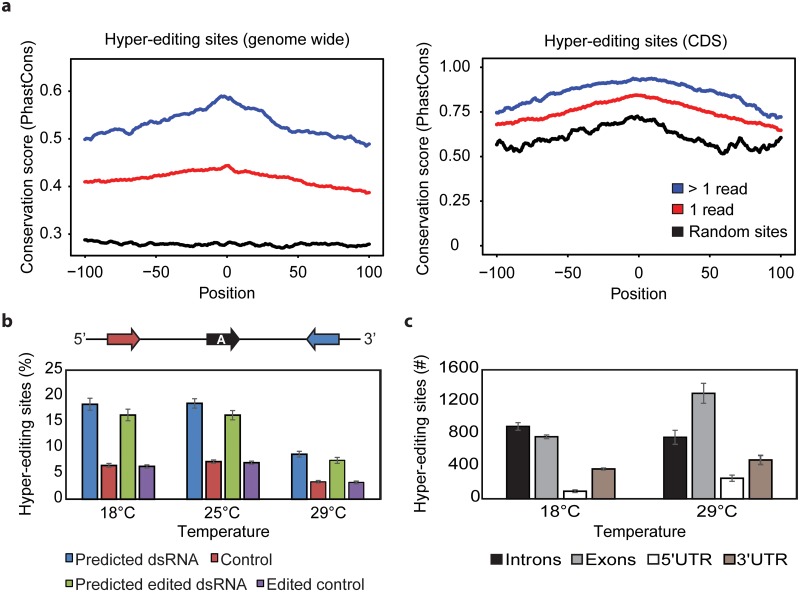
Editing sites at lower temperatures are edited more frequently and are more commonly flanked by complementary sequences.(A) Mean conservation (PhastCons) score of hyper-edited sites. Position 0 indicates the position of editing site. Blue line denotes conservation mean for editing sites supported by more than one event, red line denoted conservation mean for editing sites supported by only one event, and black line represents background conservation of chosen randomly adenosines. Left figure represents all genome wide hyper-editing sites, while the right figure represents hyper-editing sites in coding regions (CDS). The information from the non-hyper-edited reads was included. (B) RNA secondary structure prediction using BLAST[50] tool (see Methods). Blue bars donate for predicted dsRNA structure involving the hyper-editing site, as we succeeded to match the editing regions with their anti-sense sequence. Red bars denote for matches found in the sense sequence, representing the control. Green bars denote for predicted dsRNA structure involving the hyper-editing site after converting the adenosine (A) to its edited form, guanosine (G). Violet bars represents the control for the converted adenosines. (C) Genomic locations of detected hyper-editing sites show increase in the number of exonic sites at 29°C.